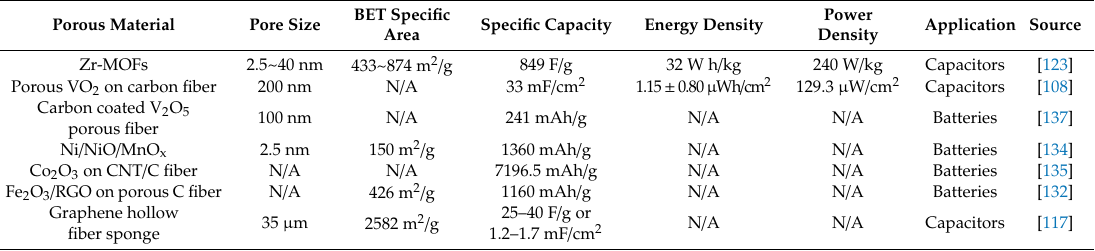
Table 2. Comparison on Key Parameters and Performances of Typical Porous